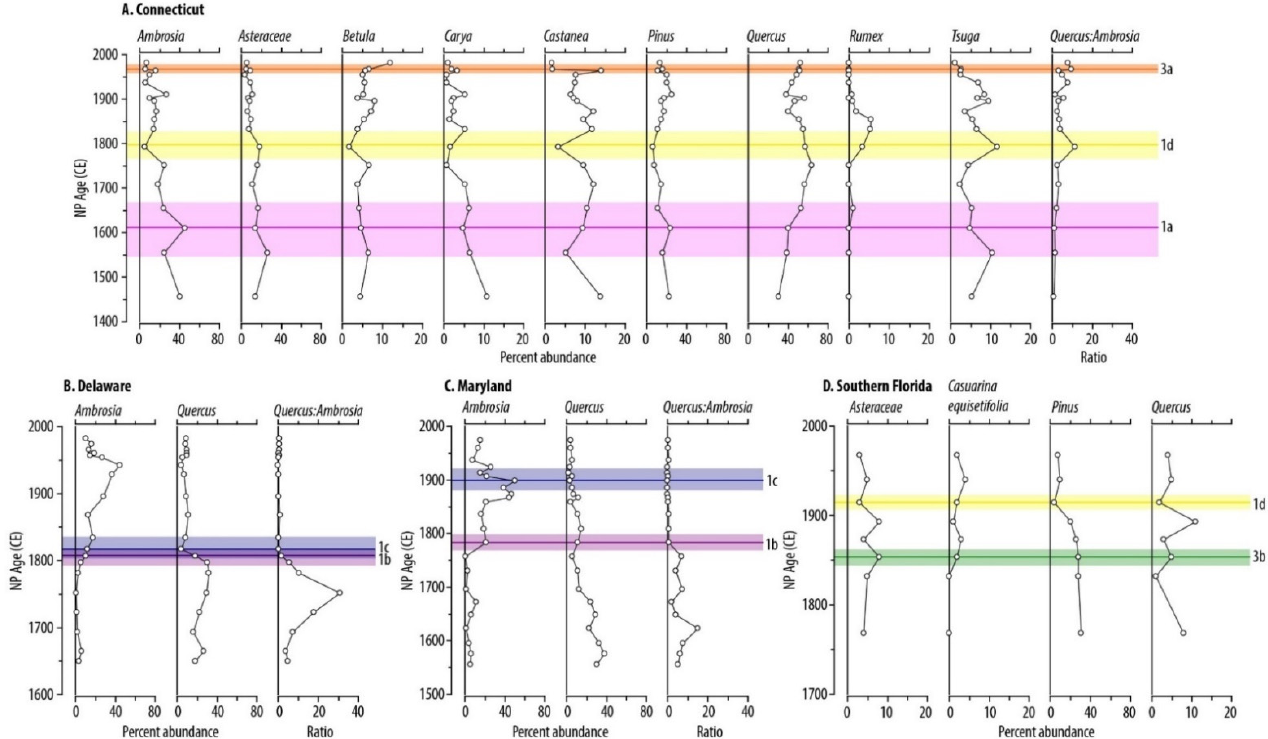
Figure 4. Pollen stratigraphic diagrams plotted against the NP Bchron predicted ages to compare the age plus uncertainty of the pollen chronohorizons with the ages derived from other age markers at the depth where the pollen chronohorizon occurred for Connecticut ( A ), Delaware ( B ), Maryland ( C ), and Southern Florida ( D ). Lines indicate the pollen chronohori- zons; shading indicates the uncertainty associated with each pollen chronohorizon. The chronohorizons are as follows: (3a) chestnut blight; (1d) beginning of the forestry industry; (1a) initial land clearance; (1c) lowest amount of forest cover; (1b) peak deforestation; and (3b) Casuarina introduction (Table 3).